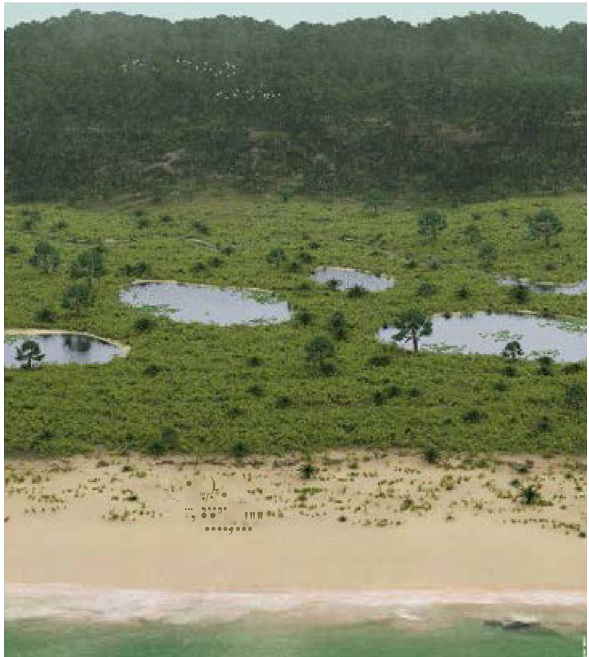
Figure 6. Reconstruction of the transitional gradient between marine to terrestrial environment (uplands) under ITCZ influence. The illustration is based on paleoflora and environmental information from palynological data from studied sections. Original size illustration: 18 × 24 cm, by Julio